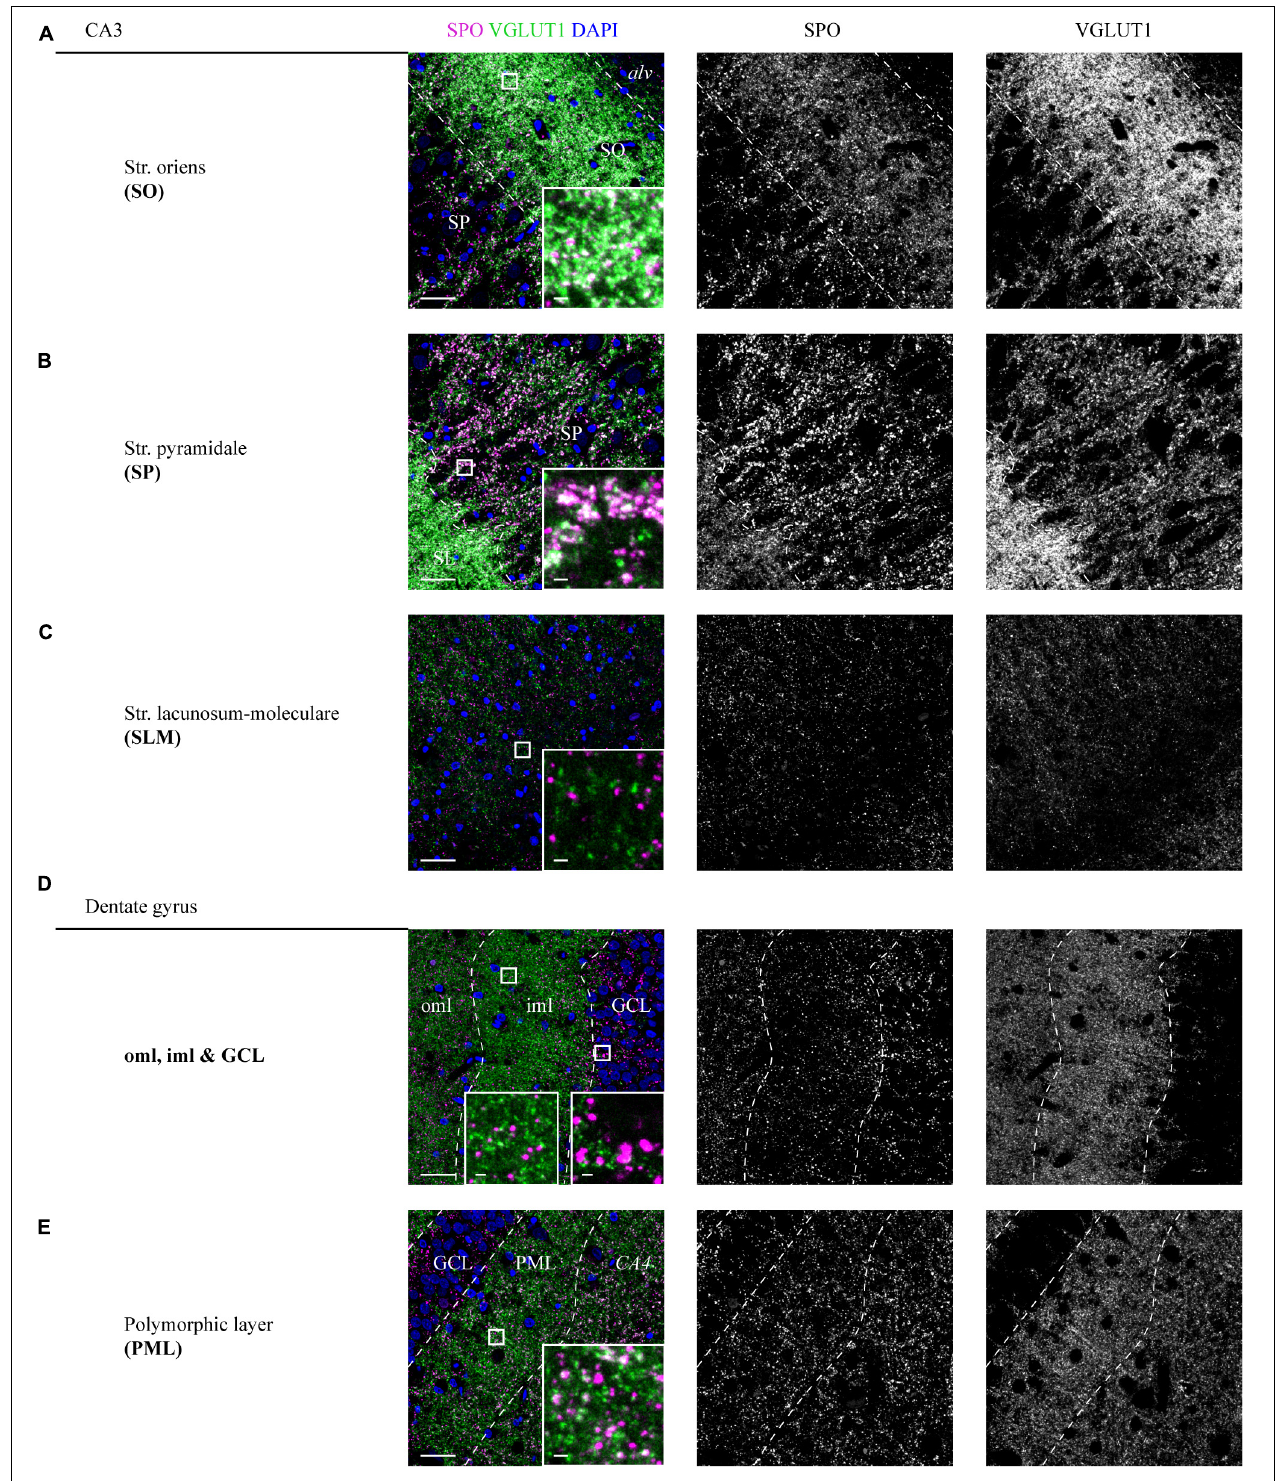
FIGURE 3 | Distribution of SPO at VGLUT1-positive synapses in CA3 and DG layers of a human hippocampus. (A–E) High-resolution z-stacks (z = 1.98 µ m) were acquired in a hippocampus section co-stained for SPO and VGLUT1. A tilescan of the VGLUT1 channel served as a map to identify the layers and define the z-stacks. Overlay of SPO (magenta), VGLUT1 (green), and DAPI (blue) is shown in the left, individual channels are shown in the middle (SPO) and right (VGLUT1) column. White squares are shown as higher magnified insets at the lower right of each image. Imaging parameters and contrast adjustments were kept constant for all images. Scale bars overviews, 30 µ m; scale bars insets, 2 µ m. Images in panels (A–E) were derived from case 1.